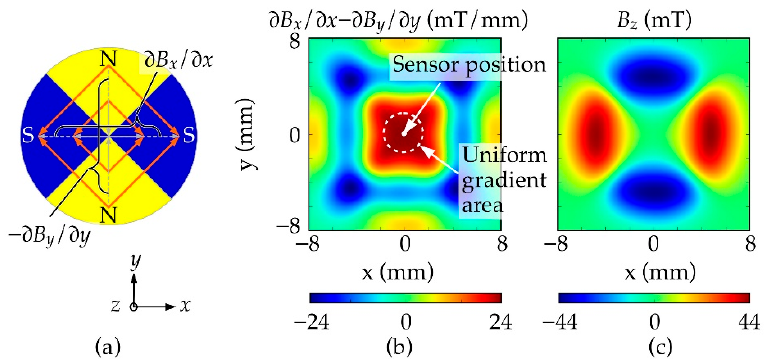
Figure 3. ( a ) Schematic illustration of the flux density gradients under a four-pole magnet. ( b ) Measured flux density gradient G = ∂ B x / ∂ x − ∂ B y / ∂ y and ( c ) magnetic flux density B z at a vertical distance of 1.5 mm under a four-pole bonded ferrite ring magnet with an outer diameter of 14 mm, an inner diameter of 5 mm, and a thickness of 3.5 mm. The flux density gradient of G = 24 mT/mm representing the sensor’s useful field source was found to be uniform in a 4 mm by 4 mm large